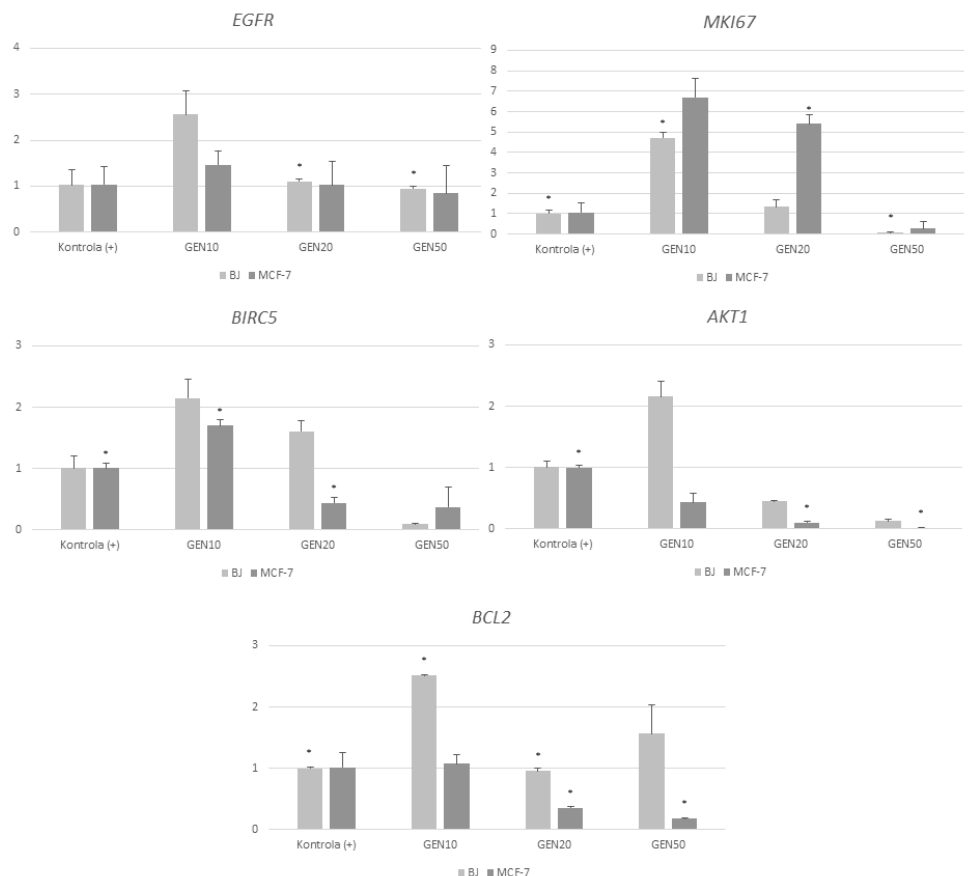
Figure 7. Analysis of gene expression in MCF-7 and BJ cells treated with genistein at different con- centrations 10, 20 and 50 μM) after 24 h Results are the mean value SD of n = 2. * Statistically significant ( p < 0.05 ANOVA Friedman along with Dunn’s multiple comparisons test compared with control group). Cells cultured with 0,1% DMSO were considered as Control (+). Cells cultured with 15% DMSO were considered as Control ( − ).